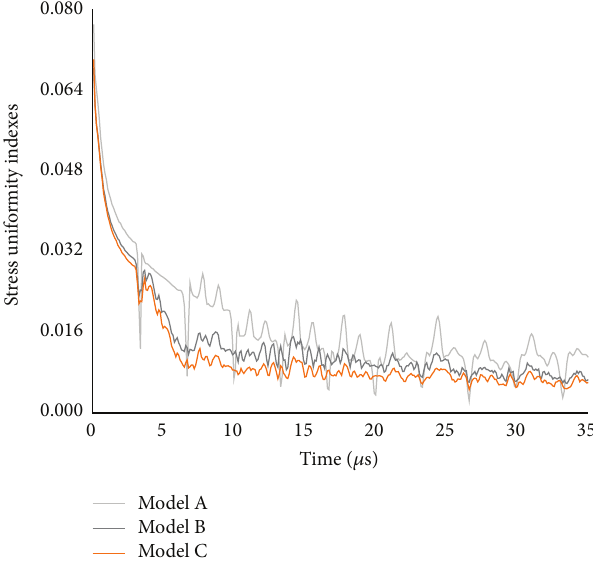
Figure 6: Stress uniformity index as a function of time for three isotropic suture